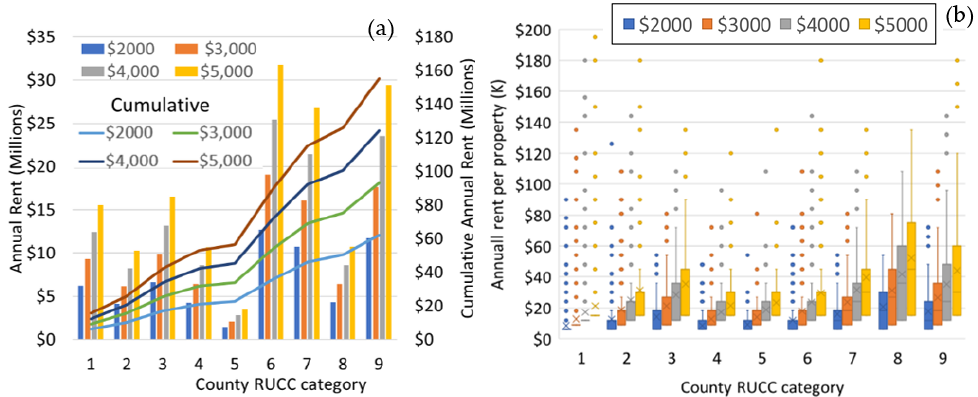
Figure 17. Assessment of rental payments on ERCOT’s future proposed wind farms for Texas categorized by USDA RUCC ( a ) Total rent per county RUCC category ( b ) Annual rent for individual lots for future proposed wind turbines.